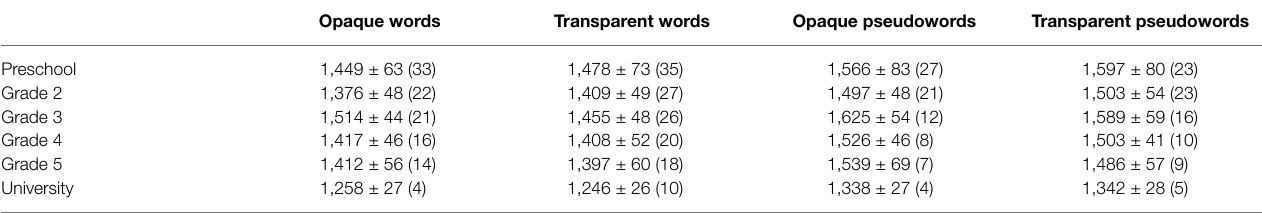
TABLE 2 | Mean ± SE for each group and